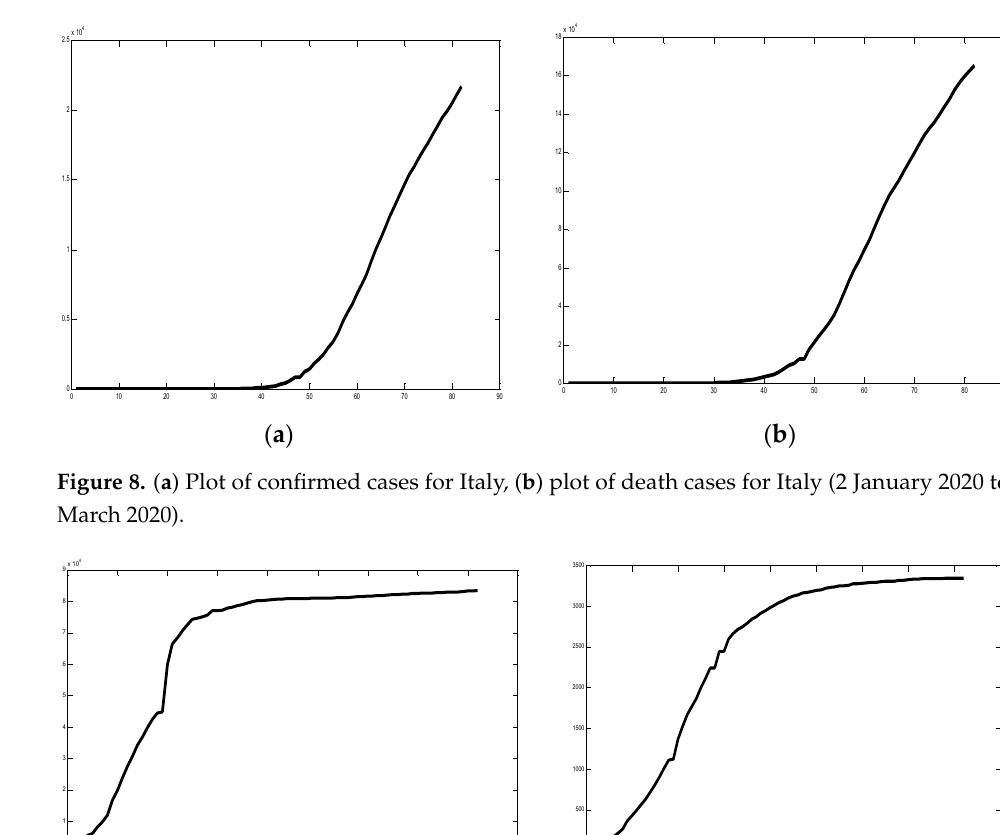
Figure 7. ( a ) Plot of confirmed cases for Belgium, ( b ) plot of death cases for Belgium (2 January